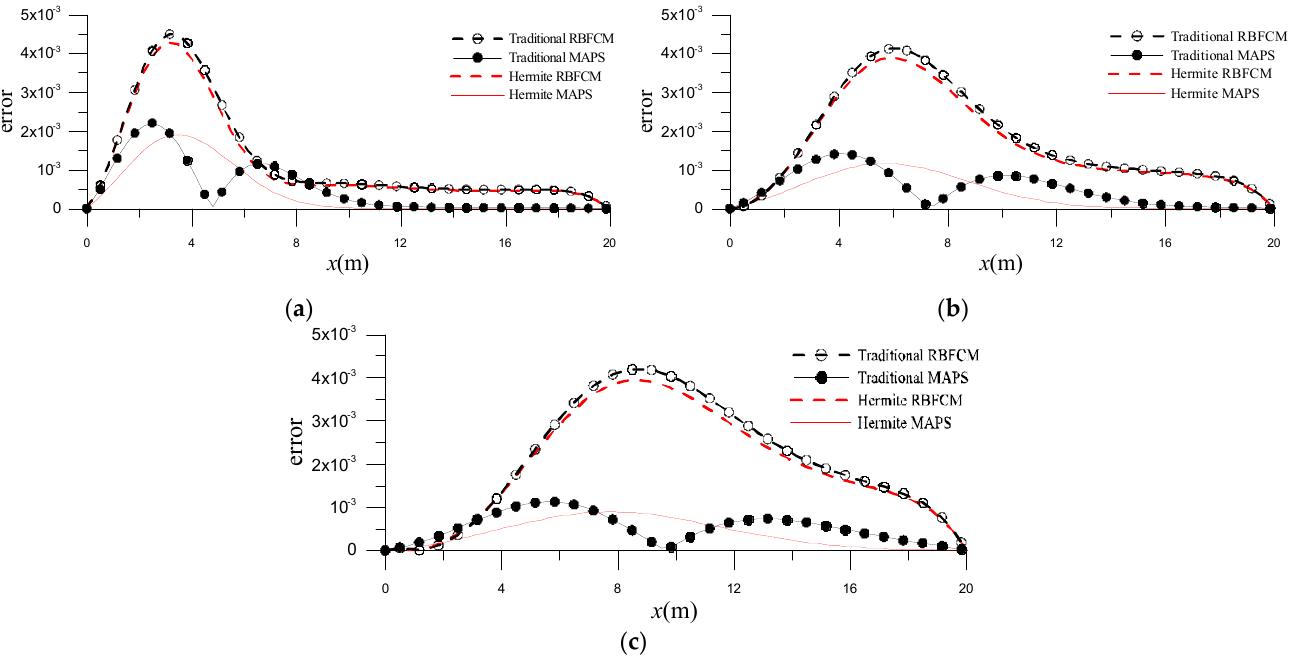
Figure 10. Errors of numerical solutions obtained by the four methods at ( a ) t = 3, ( b ) t = 6 and ( c ) t = 9 for Example